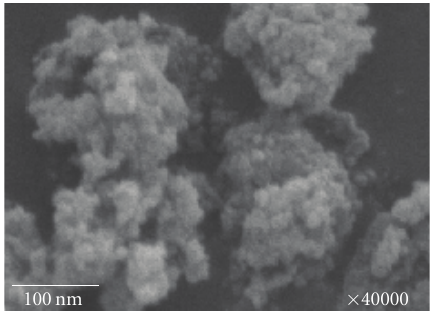
Figure 1: SEM image of TiO 2